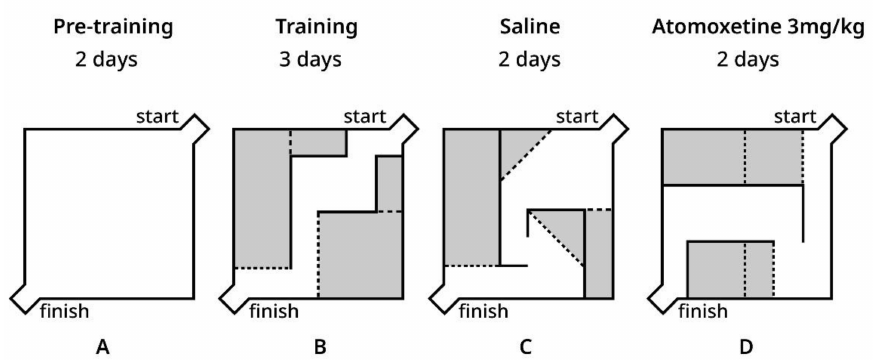
Figure 1. Layouts of the Hebb–Williams maze arenas used in experiments. ( A ) Empty arena used for familiarization during the pre-training period; ( B ) Layout used for the training period; ( C ) Layout used after saline injections; ( D ) Layout used after ATX injections. Walls indicated in black; error zones indicated in grey with dashed lines as the